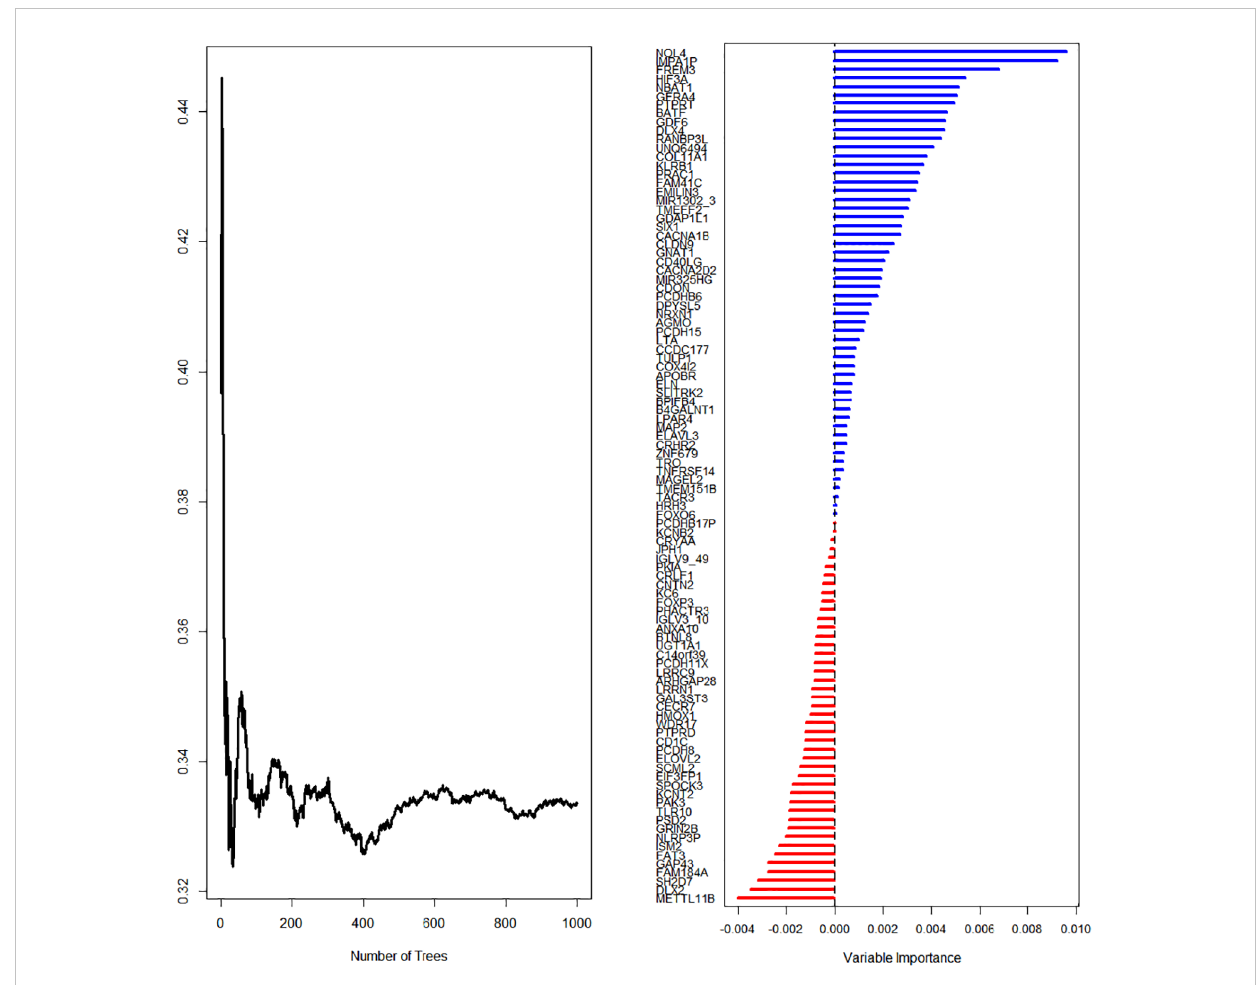
FIGURE 3 LASSO regression (iteration equal 1000) screening for survival-related mRNAs.